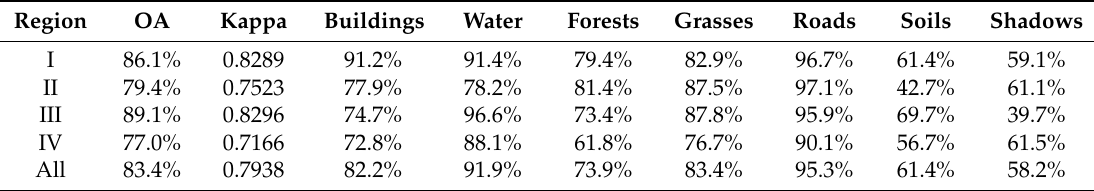
Table 4. The accuracies of the spectral-based classification approach in the four test regions in terms of overall accuracy, Kappa coefficient, and F1-score for each